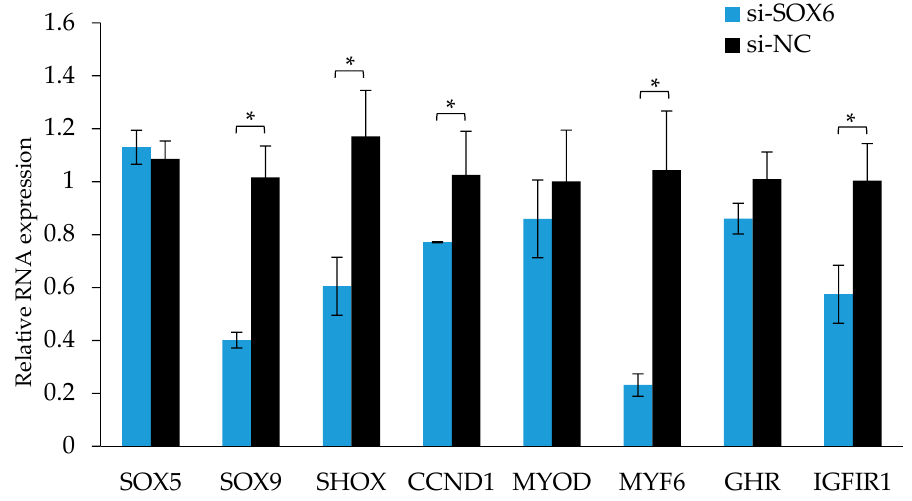
Figure 9. The RNA expression levels of candidate genes after interfering with SOX6 in the QM7 cells. Significance: * indicates p < 0.05.